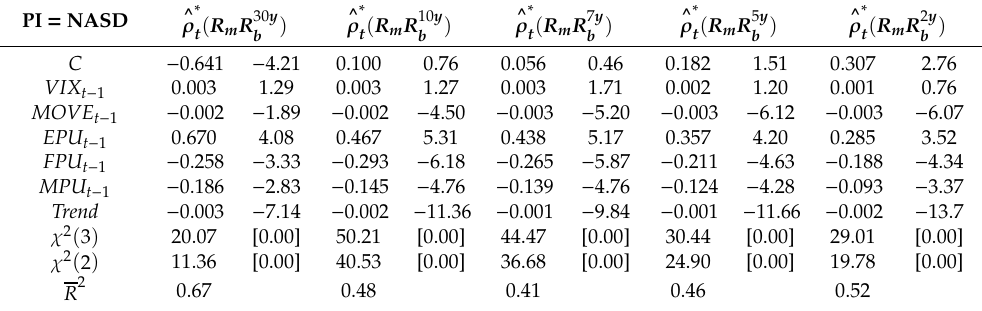
Table 6. Estimates of aggregate and categorical EPU, FPU and MPU and on stock (NASDAQ)–bond return